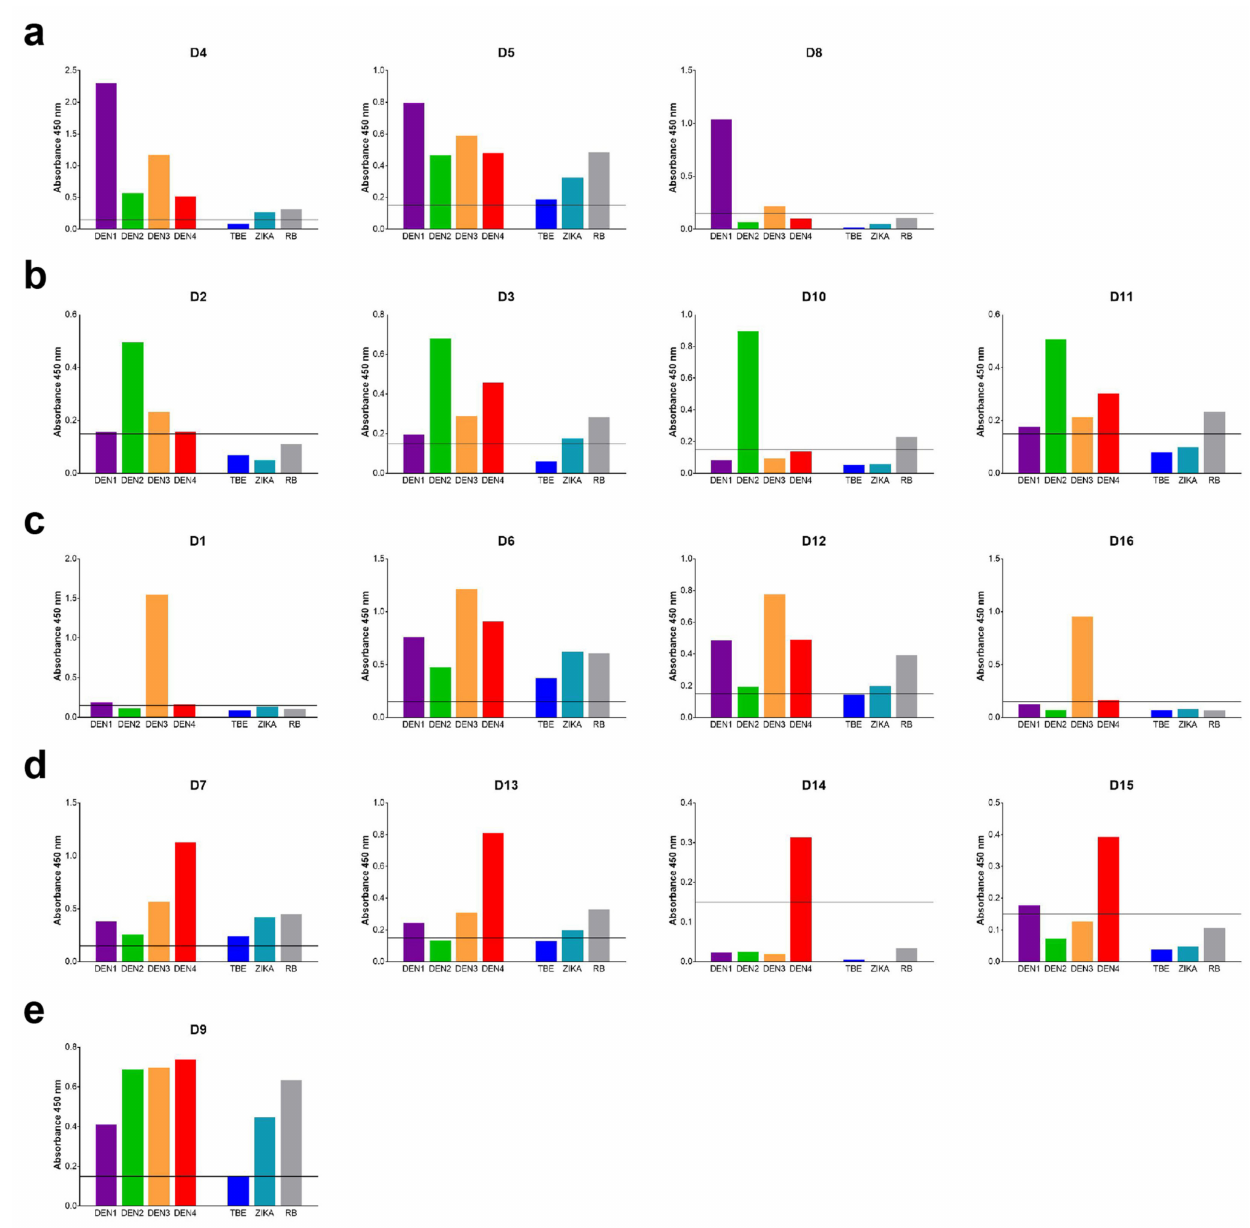
Figure 2. Comparative analysis of dengue serum samples in IgM E-complex ELISAs using the sE antigens of DEN1, DEN2, DEN3, DEN4, TBE, Zika, and Rio Bravo (RB) viruses. ( a ) PCR-confirmed DEN1 samples D4, D5 and D6. ( b ) PCR-confirmed DEN2 samples D2, D3, D10 and D11. ( c ) PCR-confirmed DEN3 samples D1, D6, D12 and D16. ( d ) PCR-confirmed DEN4 samples D7, D13, D14 and D15. ( e ) PCR-confirmed DEN2 sample D9 with a highly cross-reactive IgM pattern. Solid line: